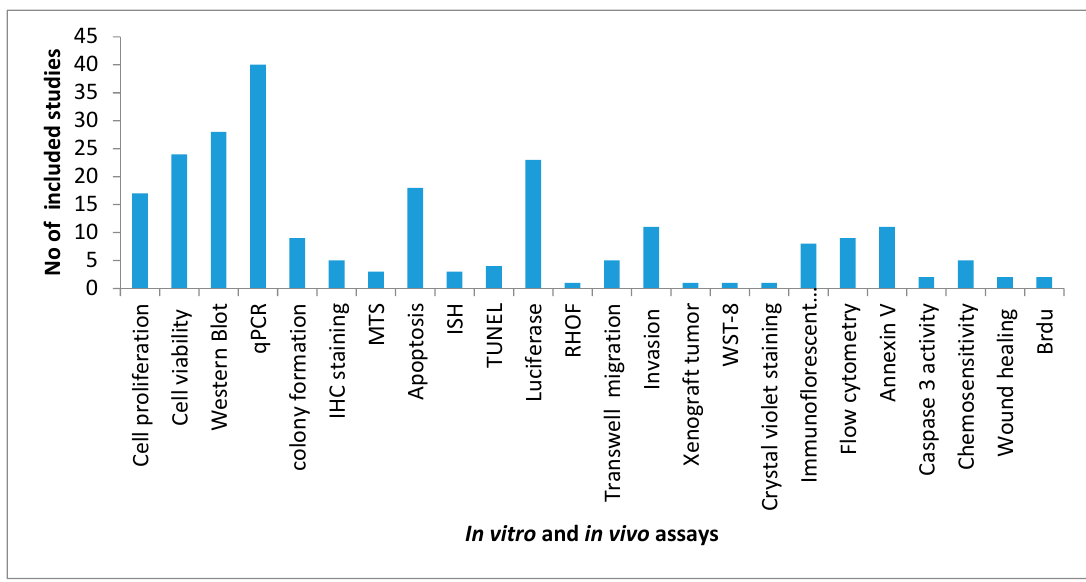
Figure 2. Commonly performed in vitro assays in the included articles. ISH: in-situ Hybridization; IHC: immuno histo-chemistry; TUNEL: terminal deoxynucleotidyl transferase (TdT) dUTP Nick-End Labeling.